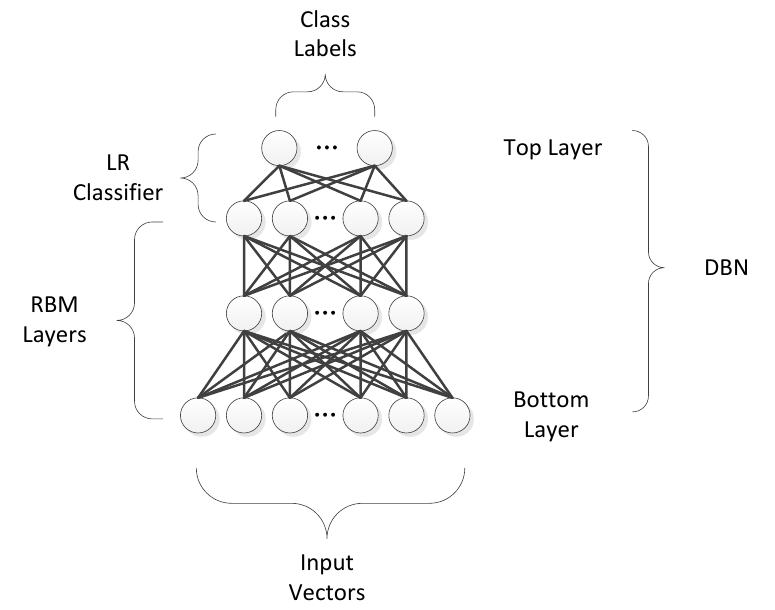
Figure 1. Architecture of a deep belief network (DBN).